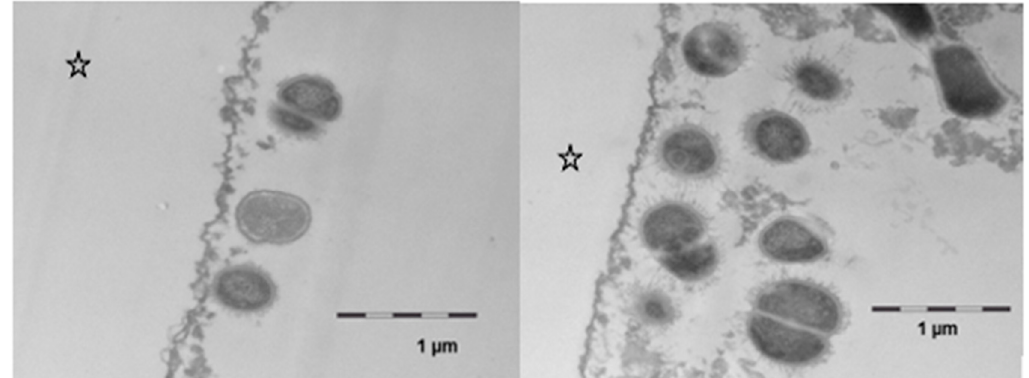
Figure 8. Transmission electron microscopy, in situ application of linseed oil for 10 min after 1 min of initial pellicle formation. The samples were kept in the oral cavity overnight for 8 h. There was a pronounced bacterial colonization, the adherent bacteria showed an intact ultrastructure and cell division was observed. No differences were observed as compared with controls. The enamel was removed during the preparation of the samples; the former enamel side is marked with an asterisk.